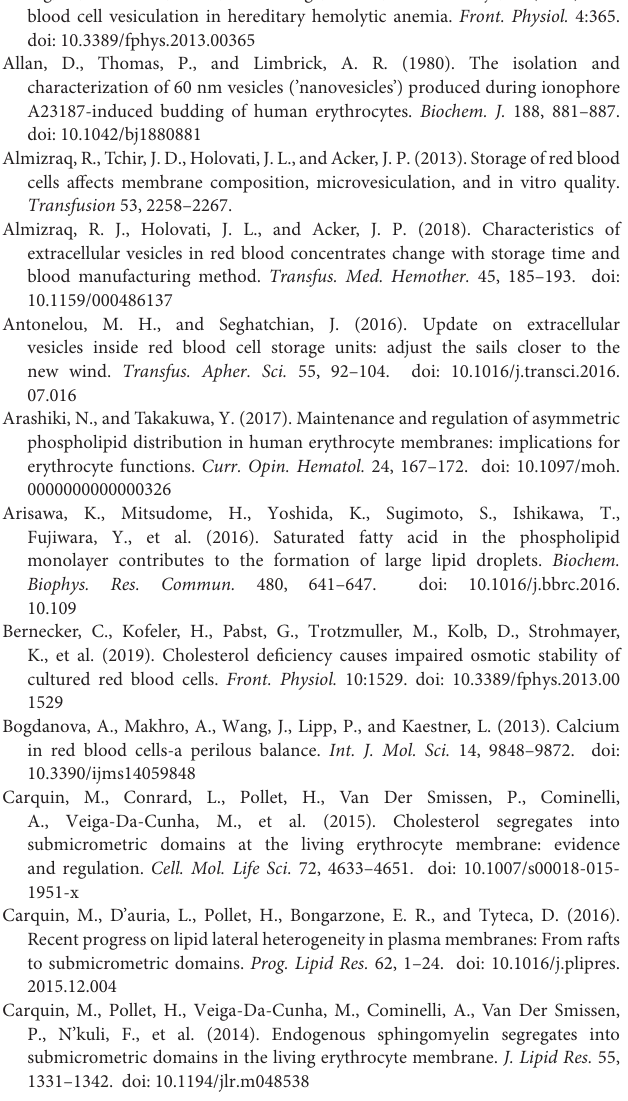
FIGURE S6 | Plasmatic pH levels are only very slightly decreased upon storage. Plasmatic pH levels were determined in 0–4 week-stored blood samples with the GEM PREMIER 3500. FIGURE S7 | RBC- and platelet-derived EVs are successfully sorted by magnetic force. EVs were isolated by ultracentrifugation from plasmas of K + /EDTA tubes stored for 0.9 and 1.3 weeks at 4 ◦ C. EVs released from RBCs were then sorted through incubation with magnetic beads coupled to anti-GPA antibodies by magnetic force. The sorted EVs were then analyzed by Western Blot for the presence of GPA to confirm successful sorting (A) and CD41 to exclude contamination (B) . A platelet lysate and EVs isolated from 1.3 weeks-stored tubes but not sorted were used as internal controls. FIGURE S8 | RBC-derived EVs are enriched in lysophosphatidylinositol and lysophosphatidylglycerol species but depleted in their precursors at the end of storage. RBC-released EVs were isolated from total blood EVs by immunopurification and analyzed by LC-MS for their content in: (A,B) phosphatidylinositol (PI) and lysoPI species; (C–E) phosphatidylglycerol (PG,